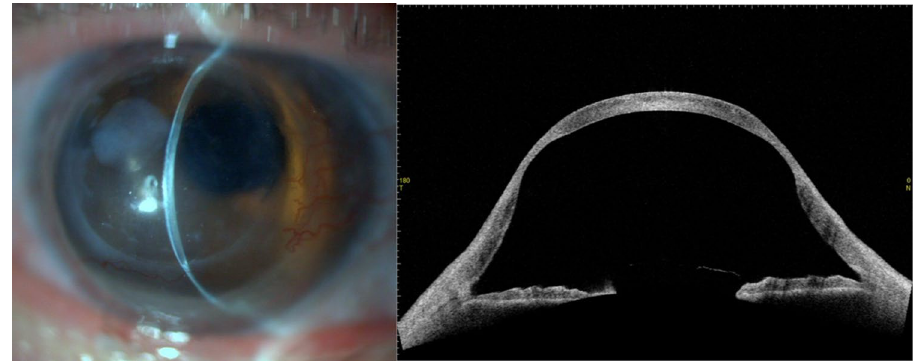
Figure 1. Representative images of an eye of 65-year-old man who underwent penetrating keratoplasty for keratoconus 36 years ago. The corneal thinning in the mid-peripheral area and corneal protrusion are